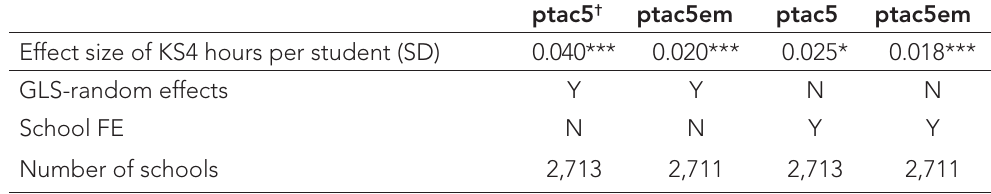
Table 4: Effect size (SD) of KS4 instruction time and attainment at school level